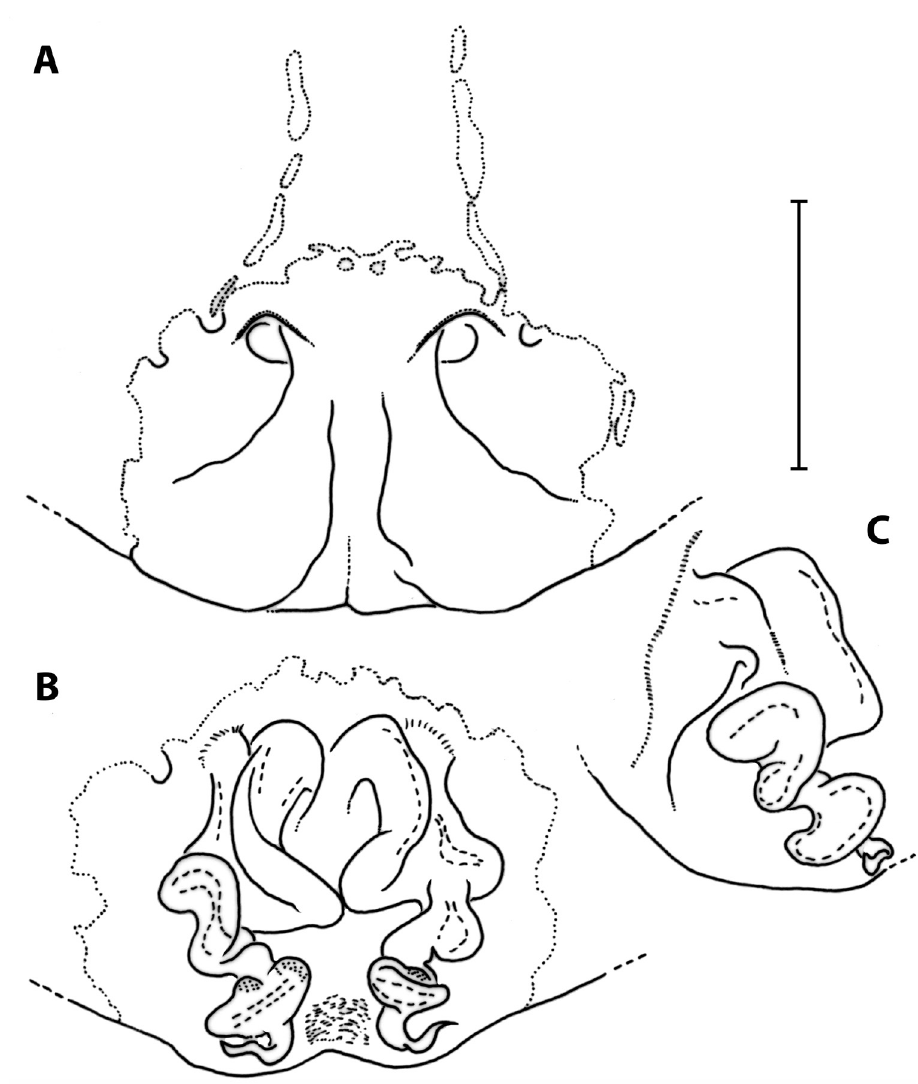
Figure 5. Spariolenus mansourii sp. n., female paratype, Kohgiluyeh and Bouyer-Ahmad Province, Nezel Cave entrance, Iran (ZMUI). A epigynum, ventral B vulva, dorsal C right vulva, lateral. Scale bar: 1 mm. Palp . As in diagnosis, with cymbium 1.5 times longer than tibia, BRB present, RTA short, dRTA 2 times longer than vRTA, both distally rounded in ventral view, PET and RET both pointed distado-prolaterad, PET shorter than RET. Conductor hyaline and extending beyond ET in ventral view (4A–D). Female : Measurements . Medium-sized Sparassidae; total length 15.4, carapace length 7.6, width 6.1, anterior width 3.7, opisthosoma length 7.8, width